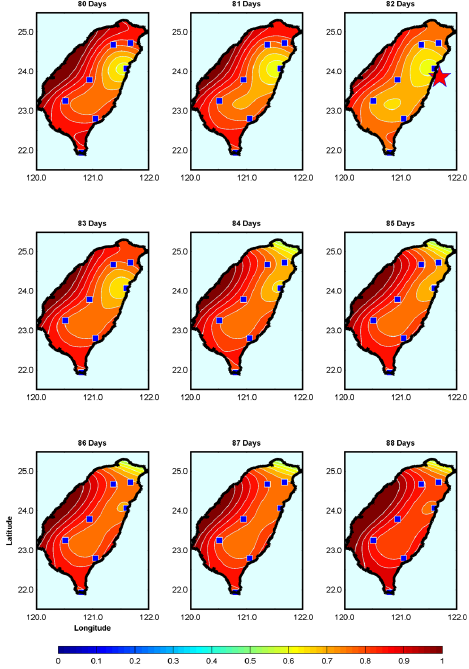
Fig. A3. A contour map of the cross correlation values from nighttime data during EQ6 (the red star).